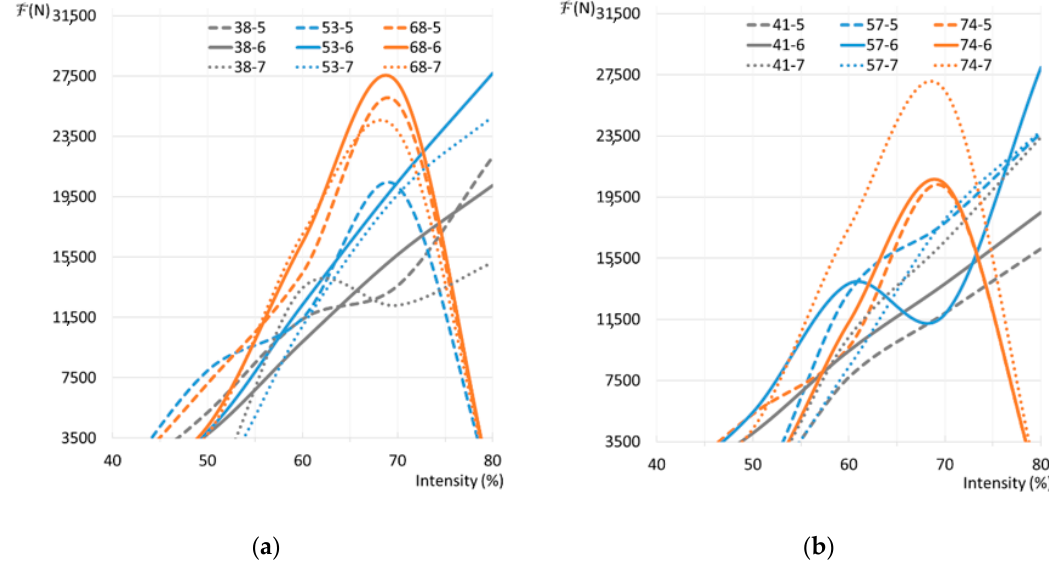
Figure 12. Force necessary for failure. Weld thickness: 24 mm (a) and 26 mm (b).